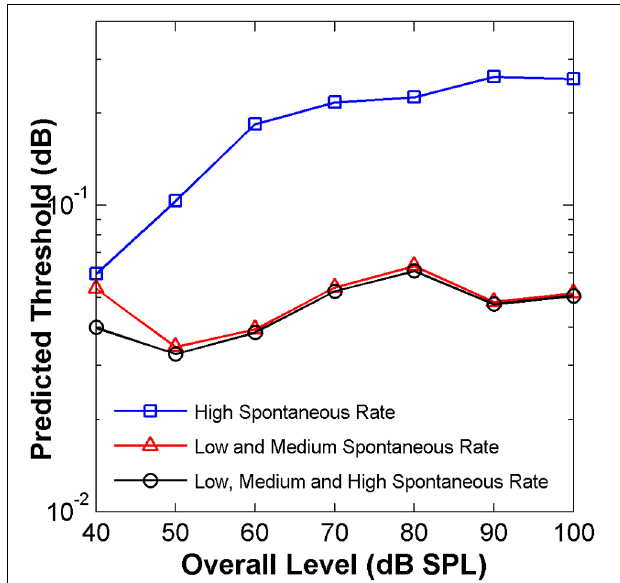
FIGURE 8 | Auditory nerve data: predicted threshold notch depth vs . level functions from an “ideal observer” analysis of neural responses from different fiber types, as indicated in the legend. Predictions are for an analysis time window of 8ms.